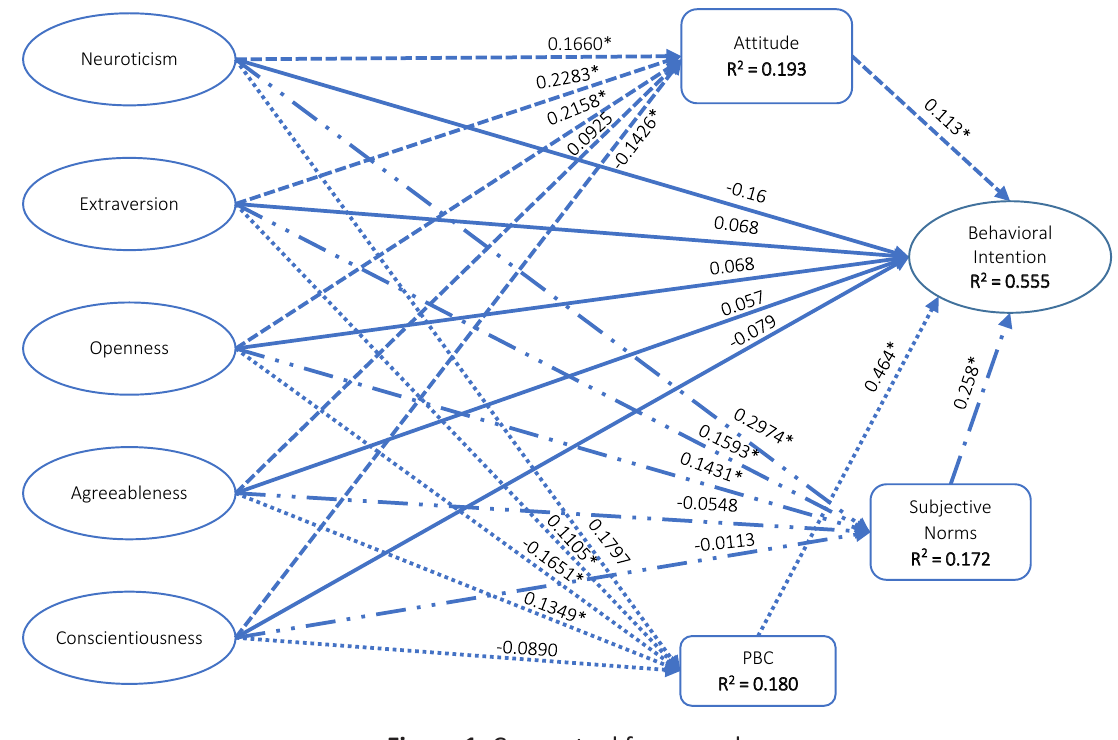
Figure 1. Conceptual